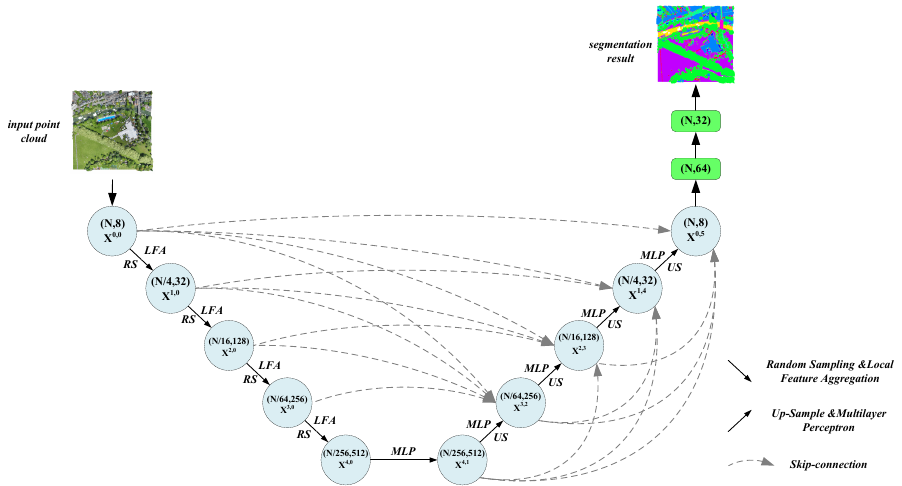
Figure 6. The structure of RandLA-Net3+. The numbers in and below the circles show the number of channels of the feature and the number of input points, respectively. RS, US, and MLP are used for random sampling, up-sampling, and multilayer perceptrons, respectively.